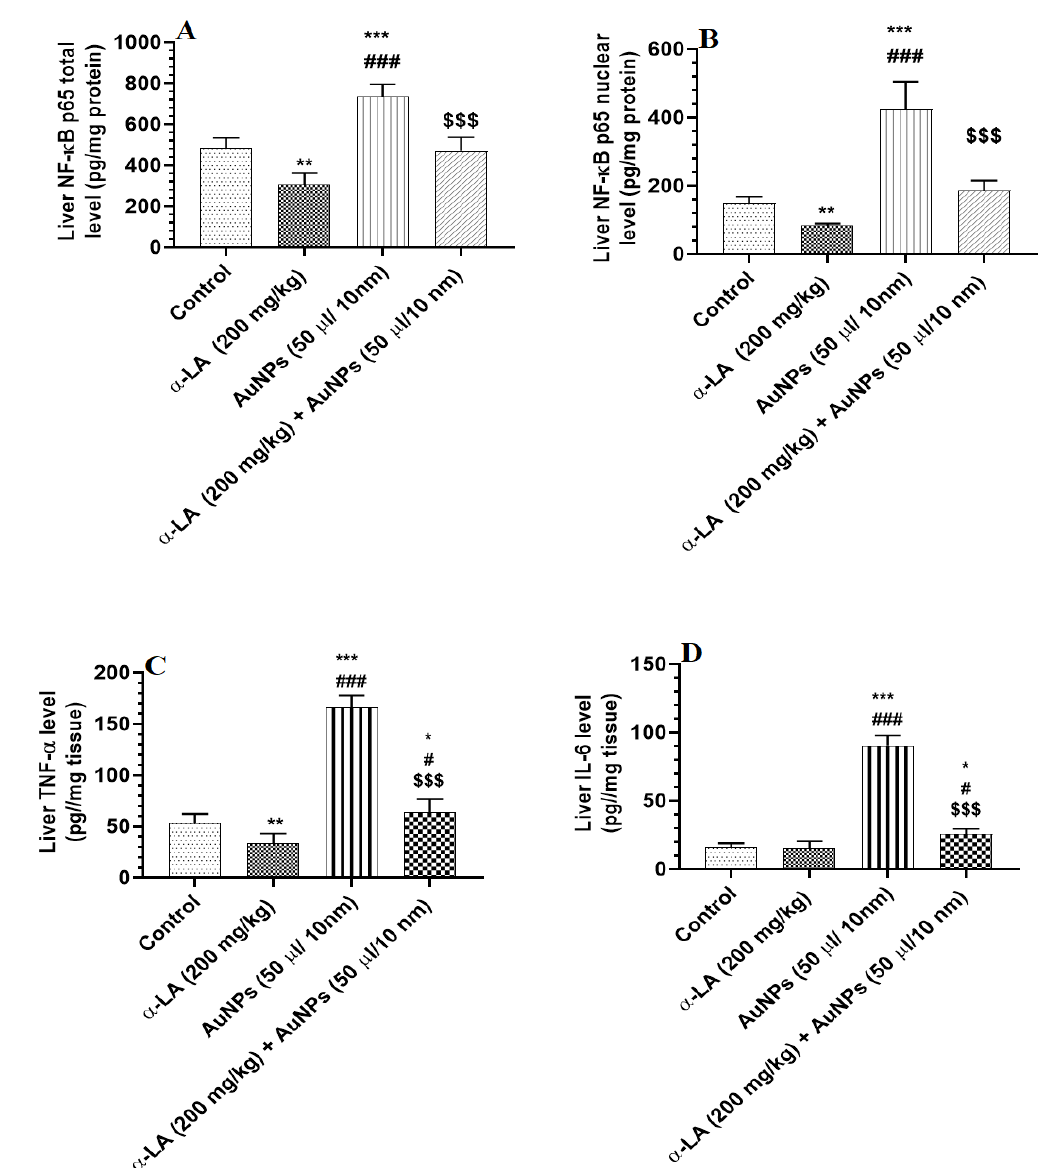
Figure 4. α -lipoic acid (LA) inhibits markers of cellular inflammation in the liver of the control and gold nanoparticles (AUNPs)-treated rats. ( A , B ) total and nuclear levels of nuclear factor kappa-beta p65 (NF- κ B p65), respectively), ( C ): levels of tumor necrosis factor-alpha (TNF- α ), and ( D ): levels of interleukin-6 (IL-6) in the livers of rats of all treated groups. All measurements were conducted by ELISA. Data were given as means ± SD (n = 8/group). p < 0.05. *, **, ***: vs. control at p < 0.01, 0.001, and 0.0001, respectively; #, ###: vs. α -LA at p < 0.01 and 0.0001, respectively; and $$$: vs. AuNPs at p <